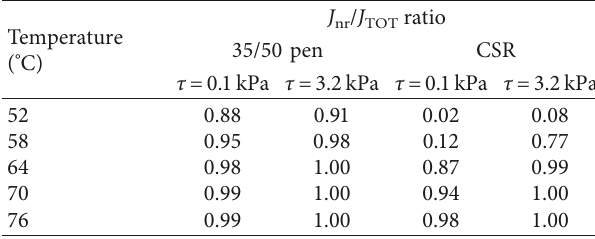
nr /J TOT ratios.